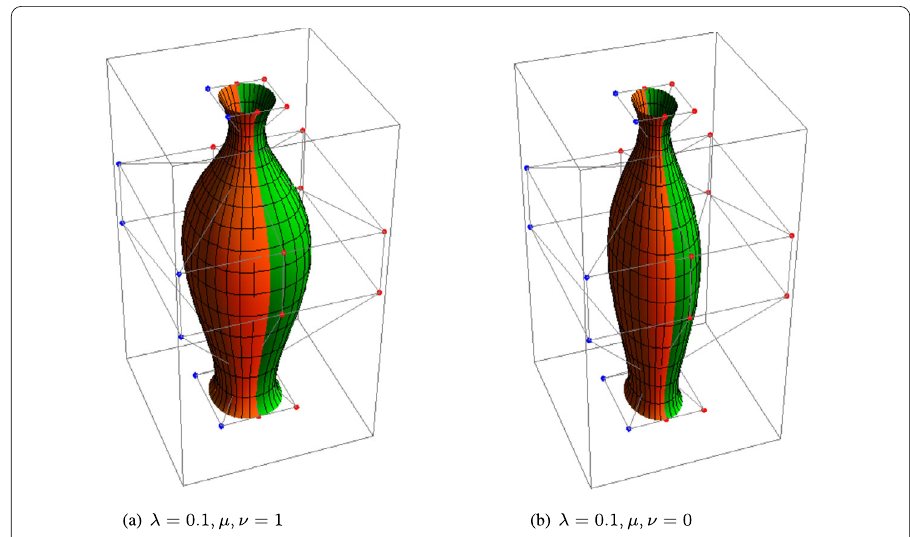
Figure 17 C 1 continuous connection among two GBT-Bézier swung surfaces